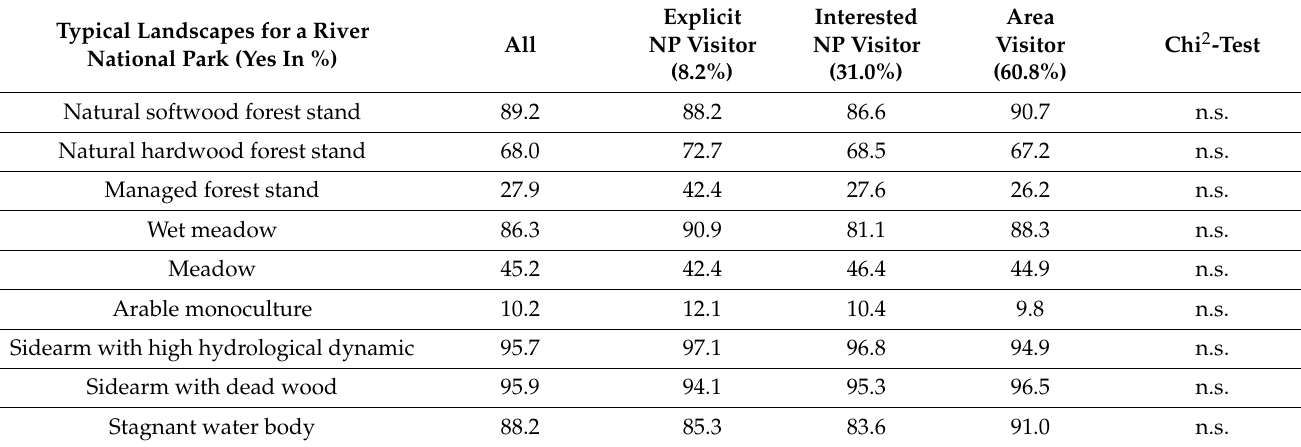
Table 6. Assessments of DANP landscapes (Figure 2(a)–(i)) by respondents (n =